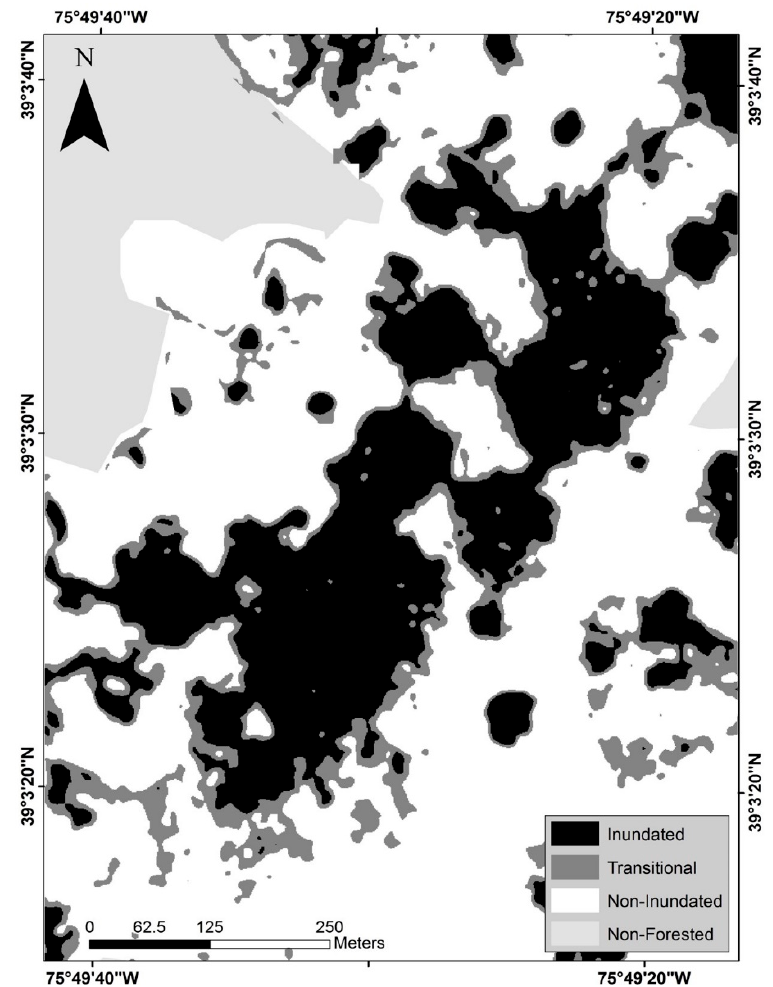
Figure 8. Inundation map for 27 March, 2007 featuring inundated and non-inundated forest classes, as well as the transitional class. Note that the transitional class is generally found adjacent to the inundated class, but it is also found on hummocks within inundated areas, along ditches, and in other areas of low elevation.